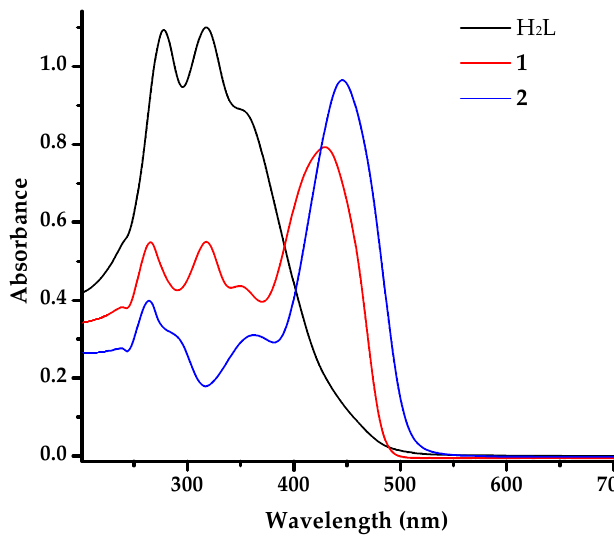
Figure 1. UV–Vis spectra of H 2 L, 1 , and 2 (1.6 × 10 − 4 M) in DMSO.